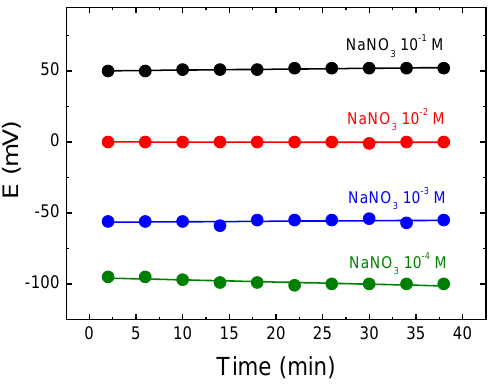
Figure 9. The reproducibility of the sensor based on (NaI) 15 (Ga 2 S 3 ) 23 (GeS 2 ) 62 glass membrane in different concentrations of the standard NaNO 3 solution. The lines are drawn as guides to the eyes.